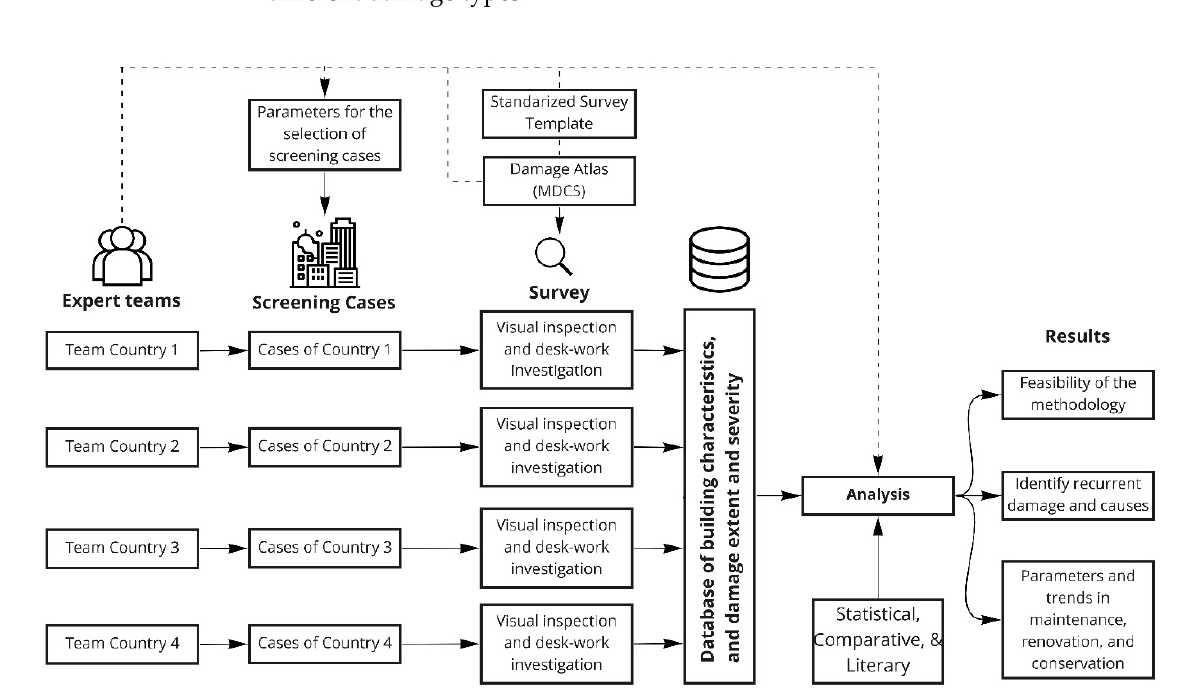
Figure 2. Flow chart of the proposed methodology.